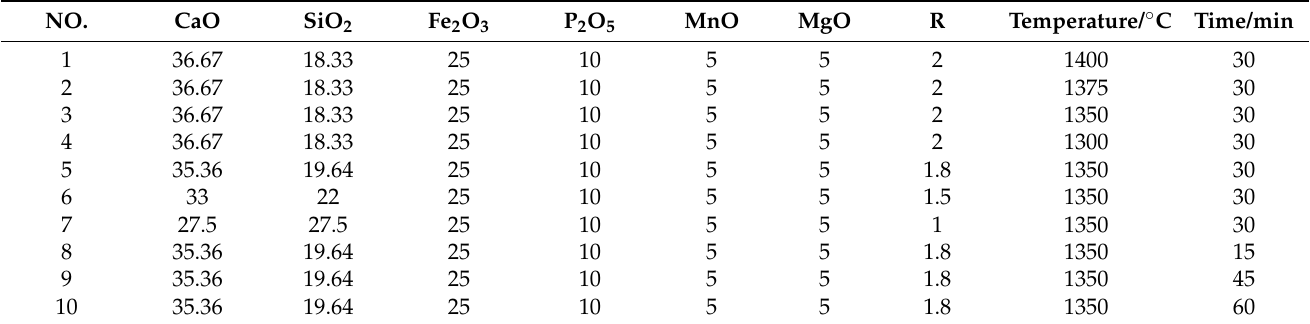
Table 1. Slag composition and heat treatment method in each experiment (wt.%).